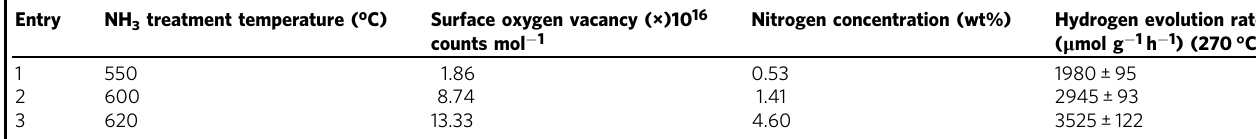
Table 1 Photocatalytic activities and oxygen vacancy concentrations of different N-doped TiO 2